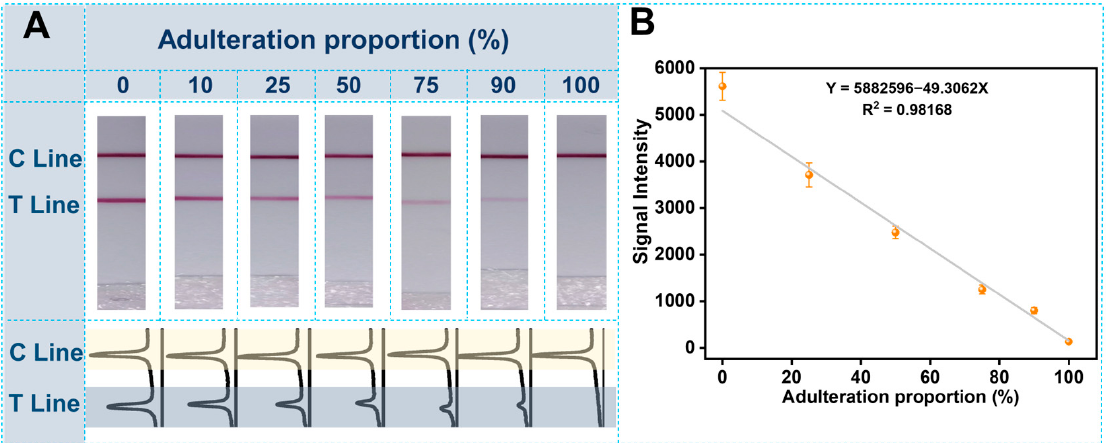
Figure 4. Authentication performance of the amplification − assisted molecular LFS: ( A ) Visual judgment results of honey samples adulterated at different ratio (0%, 10%, 25%, 50%, 75%, 90% and 100%, v / v %) and the corresponding quantitative curves analyzed by ImageJ; ( B ) Calibration curve of the authentication performance.